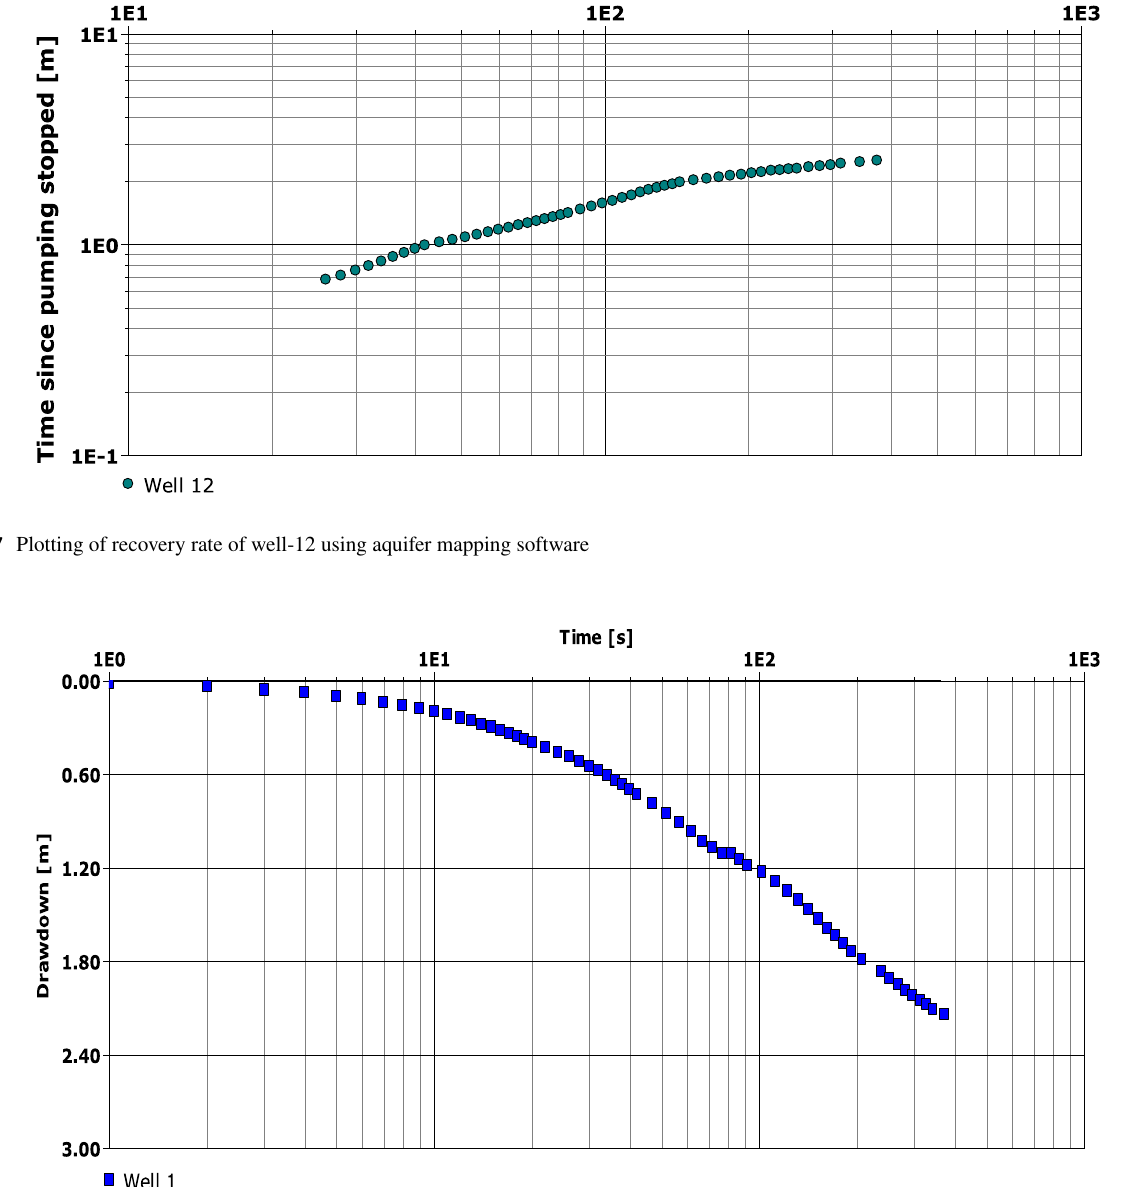
Fig. 18 Theis’s method of pumping